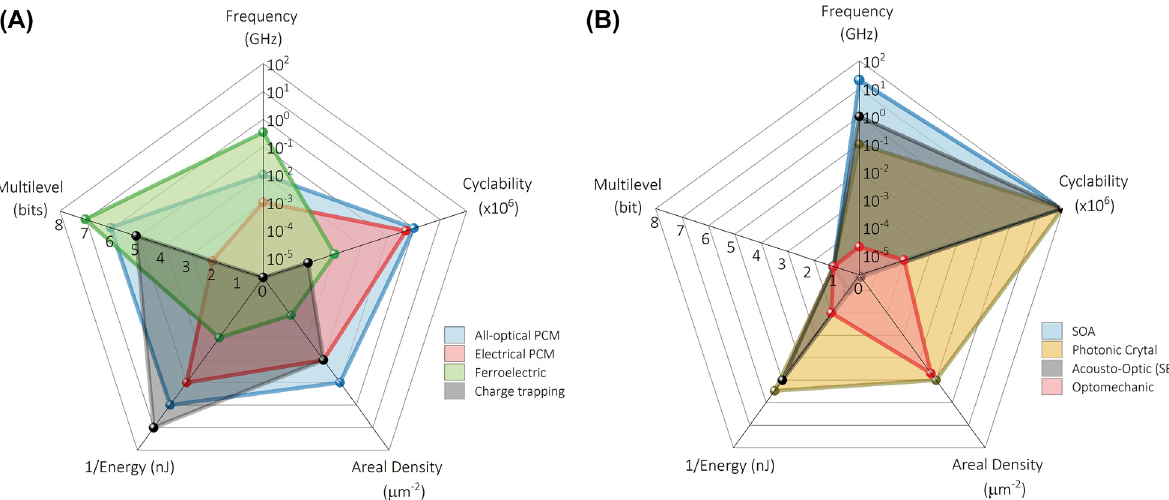
Figure 17: Comparison of photonic memories best-reported performance metrics from Table 1. (A) Nonvolatile and (B) volatile memory cells. The axes in both fi gures use the same logarithmic scale except for Multilevel . Cyclability refers to the maximum number of cycles reported for eachtechnology,whichmightdifferfrommaximumcyclability.Forsomevolatilememories,theunderpinningphysicalmechanismallowsone toassumeaverylargenumberofcycles,whichareusuallynotreported.Foreasyvisualization, cyclability inthelattercasetakesthemaximum value of the axis, yet this does not represent a limit. The value for multilevel is reported for a single memory